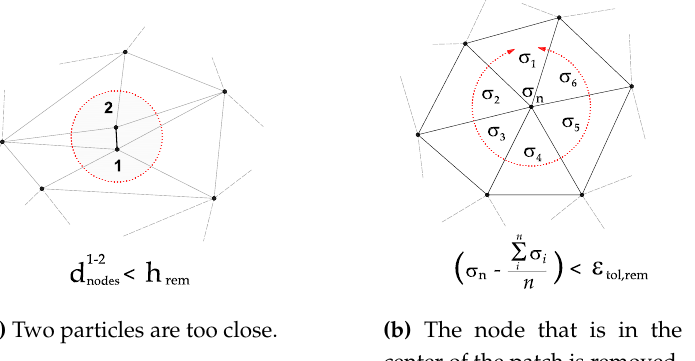
Figure 2. Three main criteria to remove a